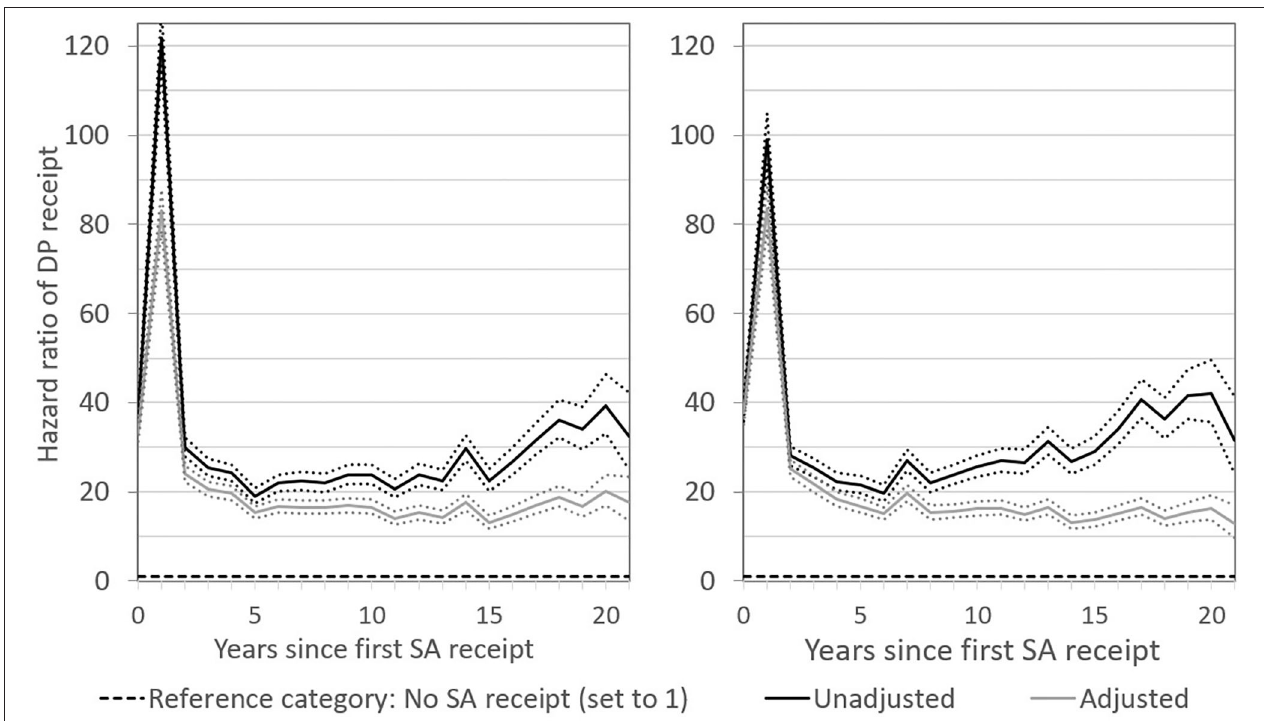
FIGURE 1 | Hazard ratios of DP receipt after first SA receipt in the short and long term. Results for men are presented in the left-hand panel and for women in the right-hand panel. Numbers reported are unadjusted and adjusted estimates with 95 percent confidence